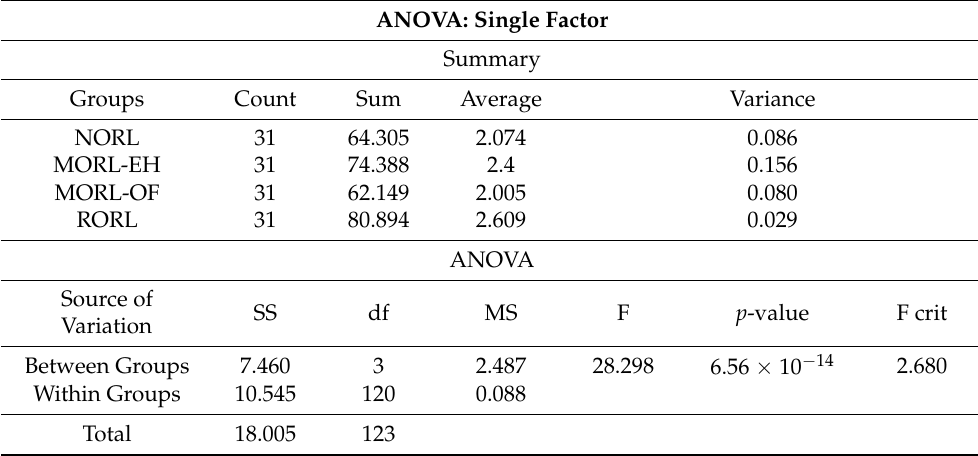
Table 7. Summary of ANOVA results from the 5-day drawdown rate. ANOVA: Single